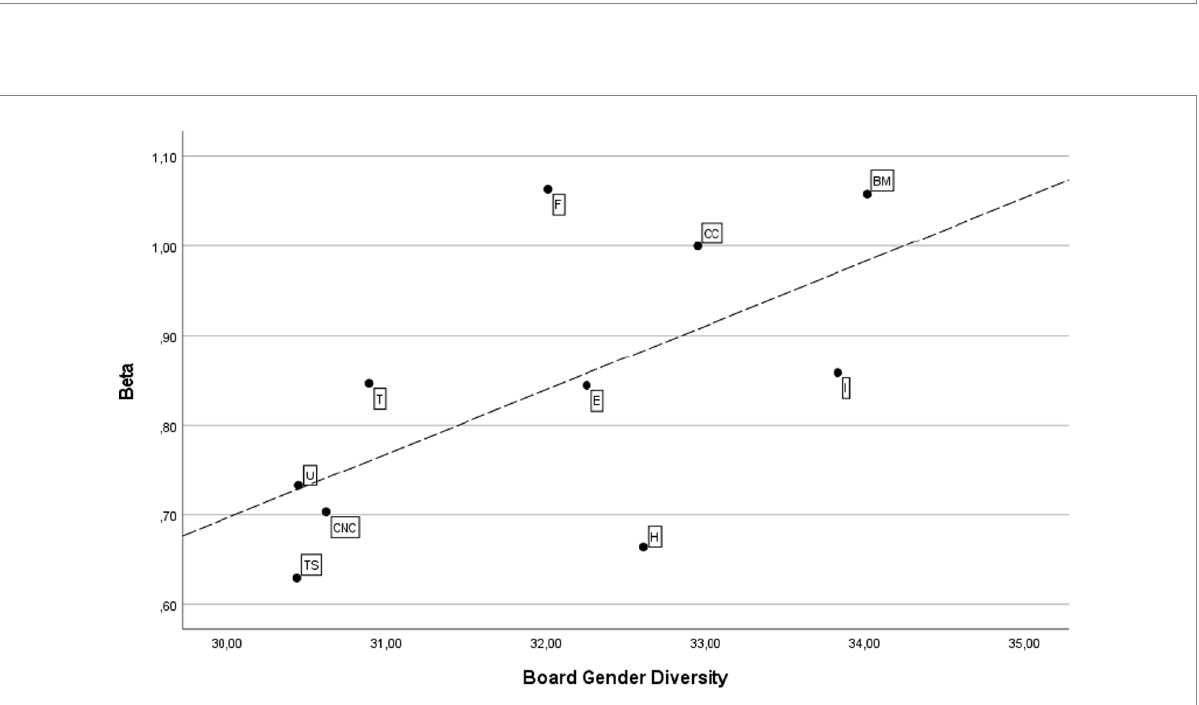
FIGURE 2 Scatter graph and fitted values by sectors in the EU market. B, Basic Materials; CC, Consumer Cyclicals; CNC, Consumer Non-Cyclicals; E, Energy; F, Financials; H, Healthcare; I, Industrials; T, Technology; TS, Telecommunication Services; U,